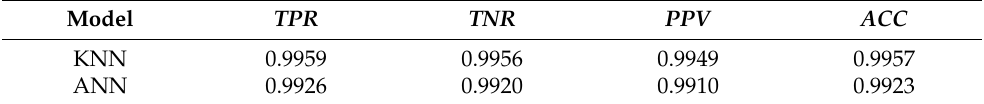
Table 2. Summary of the obtained results.